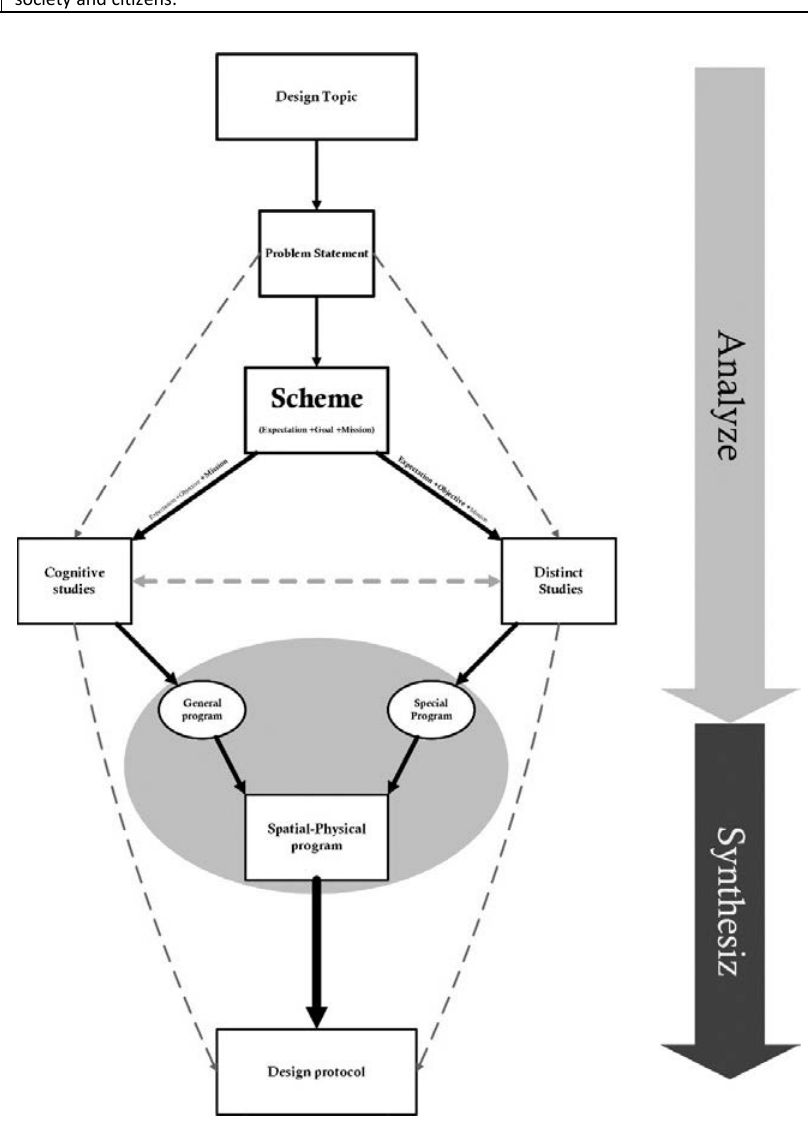
Figure 6 Research–based design